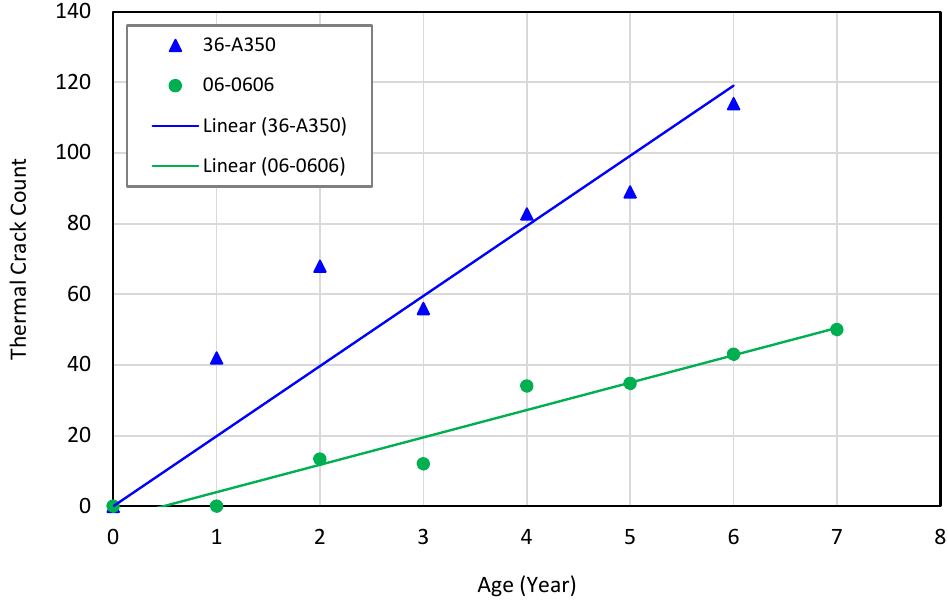
Figure 10. Thermal crack count on the LTPP test sections with low structural capacity.